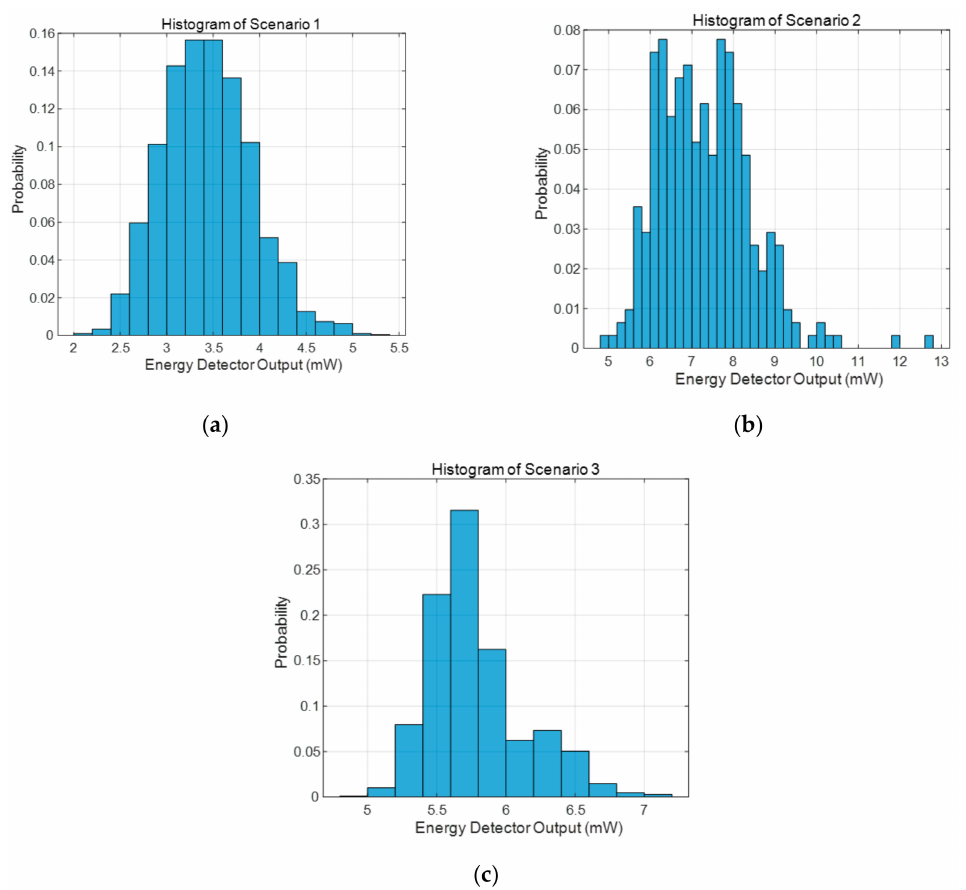
Figure 7. Energy detector output histogram: ( a ) Scenario 1; ( b ) Scenario 2; and ( c ) Scenario 3.